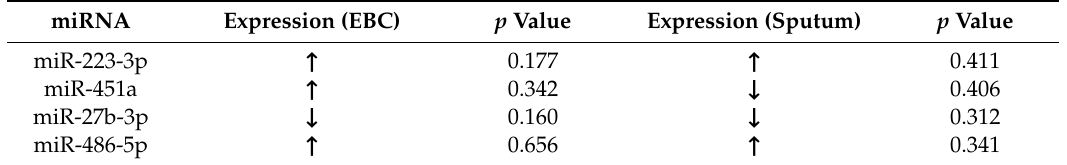
Table 3. MicroRNA (MiRNA) levels in patients during pulmonary exacerbation in reference to stable Table 3. MicroRNA ( MiRNA) levels in patients during pulmonary exacerbation in reference to stable period.